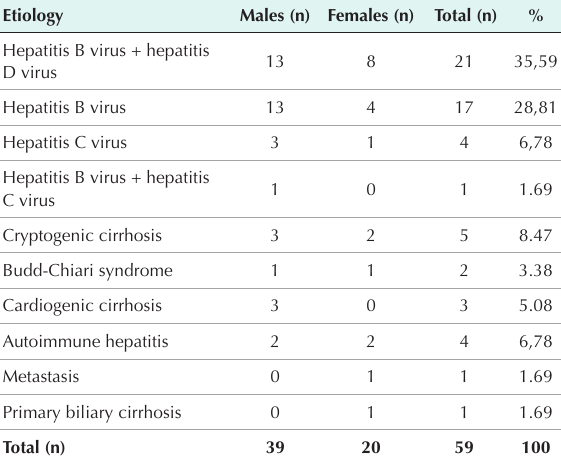
Table 2. Distribution of Patients According to Etiology and Gender Etiology Males (n) Females (n) Total (n) % Hepatitis B virus + hepatitis D